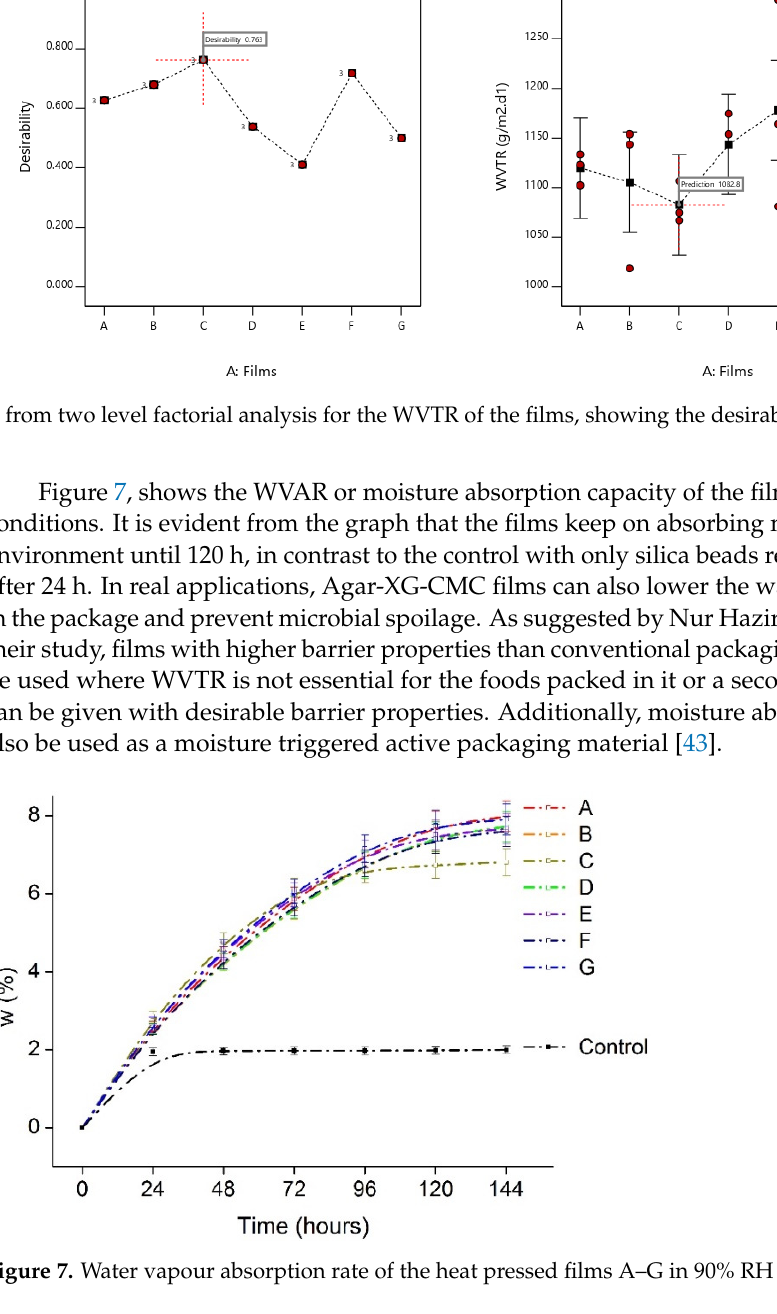
Figure 8. Absorbance of the heat pressed films ( A – G ) from wavelength 200 nm to 800 nm.